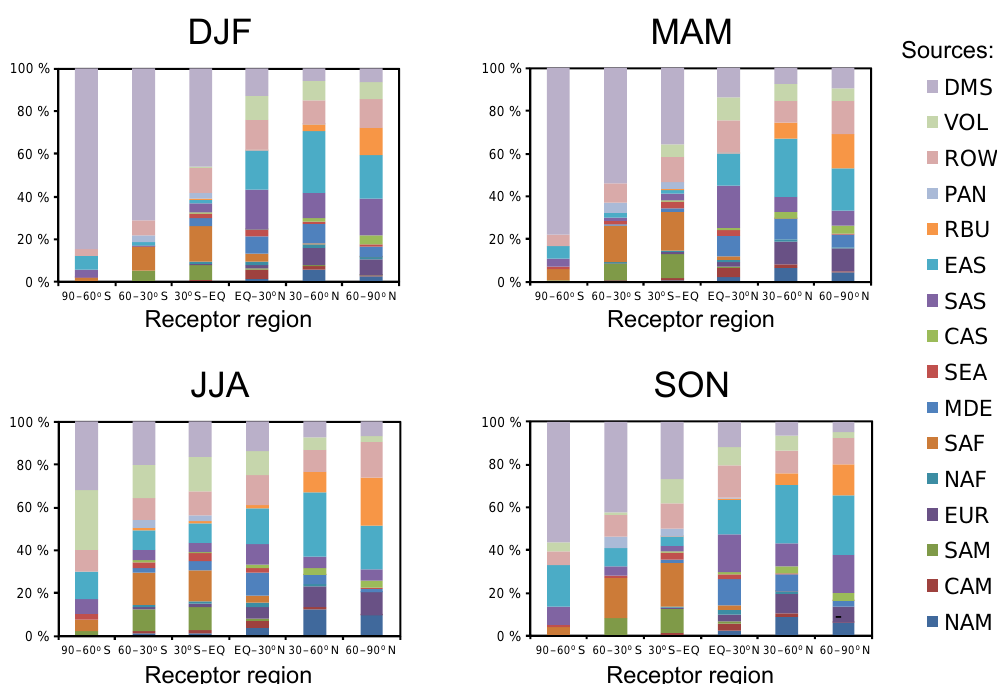
Figure 9. Relative contributions (%) from emissions in the 16 tagged regions/sectors to sulfate direct radiative forcing over the Southern Hemisphere high latitudes (90–60 ◦ S), Southern Hemisphere mid-latitudes (60–30 ◦ S), Southern Hemisphere tropics (30 ◦ S to Equator), Northern Hemisphere tropics (Equator to 30 ◦ N), Northern Hemisphere mid-latitudes (30–60 ◦ N) and Northern Hemisphere high latitudes (60–90 ◦ N).